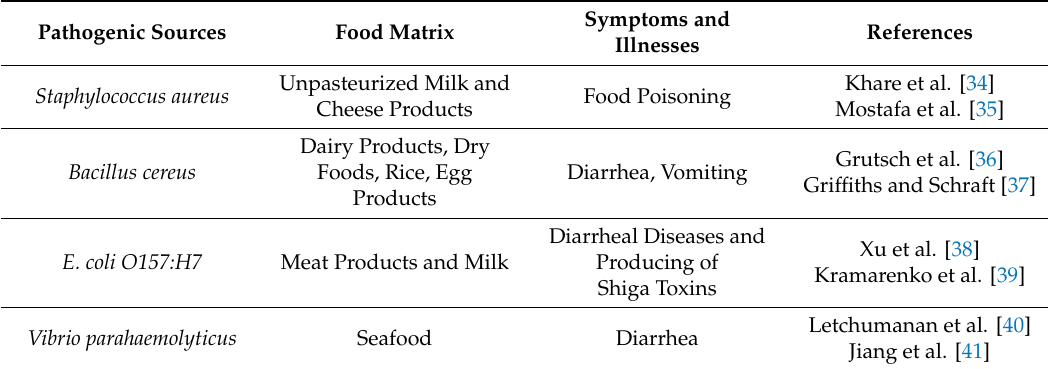
Table 1. Examples of Foodborne Diseases Caused by Microorganisms in the Food